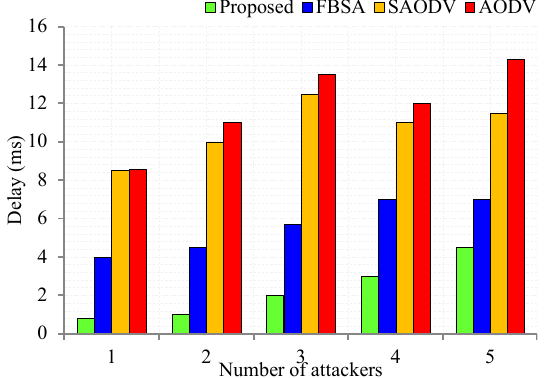
Figure 9 . Comparative analysis on delay